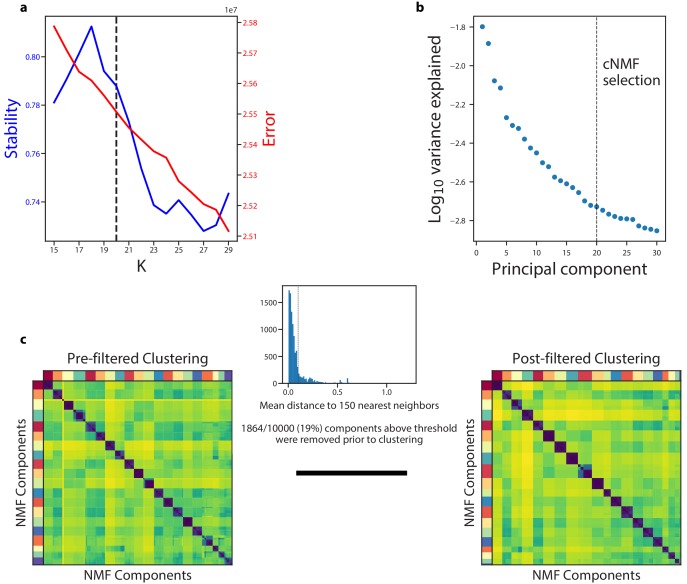
Diagnostic plot for cNMF on the Hrvatin et al. (2018) visual cortex dataset.(a) Number of cNMF components (K) against solution stability (blue, left axis) measured by the silhouette score and Frobenius error of consensus solution (red, right axis). (b) Plot of the Log10 proportion of variance explained per principal component, with the K selection used in the manuscript indicated with a dotted line. (c) Clustergram showing the clustered NMF components for K = 20, combined across 500 replicates, before (left) and after filtering (right). In between is a histogram of the average distance of each component to its 150 nearest neighbors with a dashed line showing the threshold for filtering outliers.